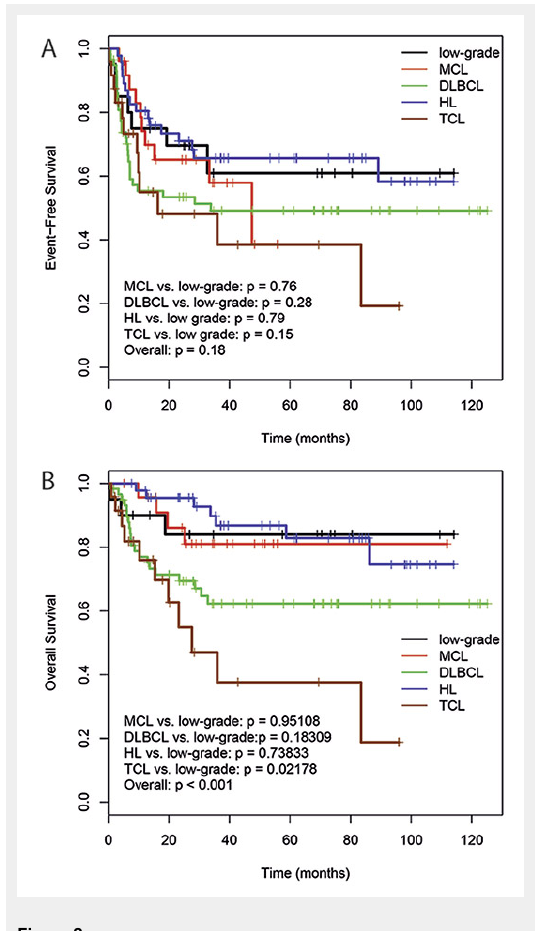
Event free survival (A) and overall survival (B) of the patients with respect to the different lymphoma subgroups. MCL, mantle cell lymphoma; DLBCL, diffuse large B-cell lymphoma; HL, Hodgkin’s lymphoma; TCL, T cell lymphoma.